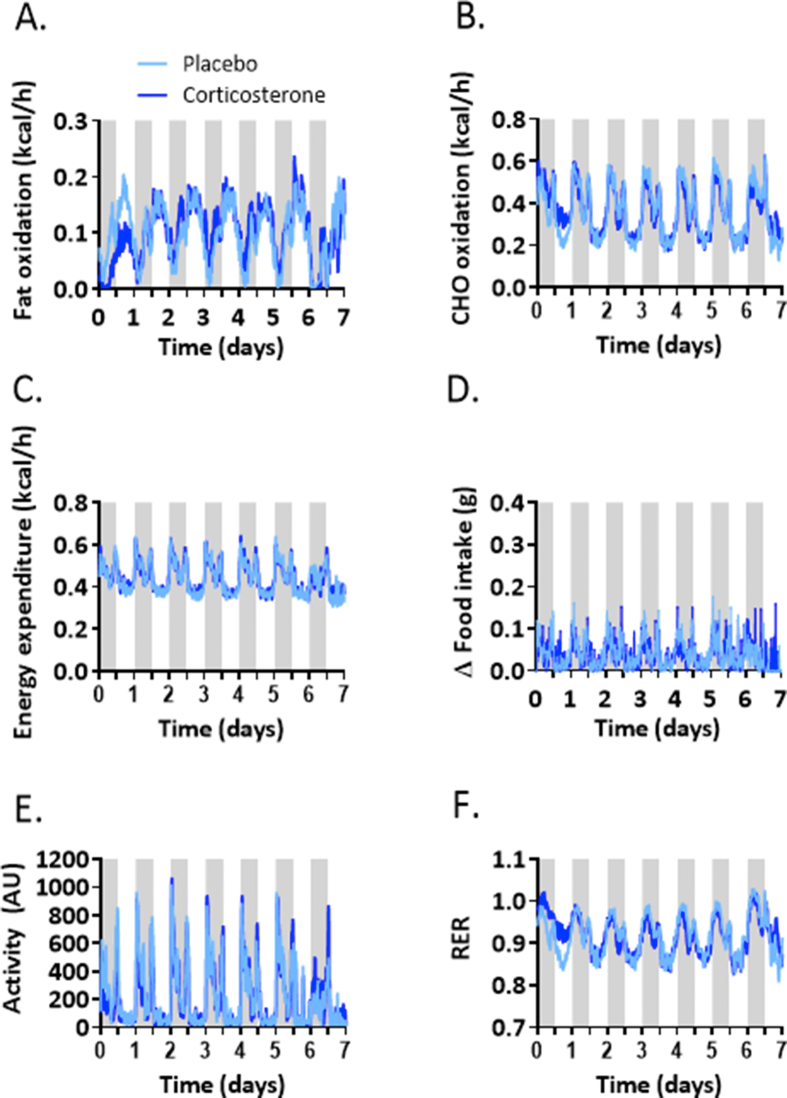
Flattening of corticosterone rhythm does not influence energy expenditure in wild-type (WT) mice. Metabolic cage measurements to determine (A) fat oxidation, (B) carbohydrate (CHO) oxidation, (C) energy expenditure, (D) food intake, (E) physical activity, and (F) respiratory exchange ratio (RER) in male WT mice implanted with placebo- and 2.5-mg corticosterone pellets.